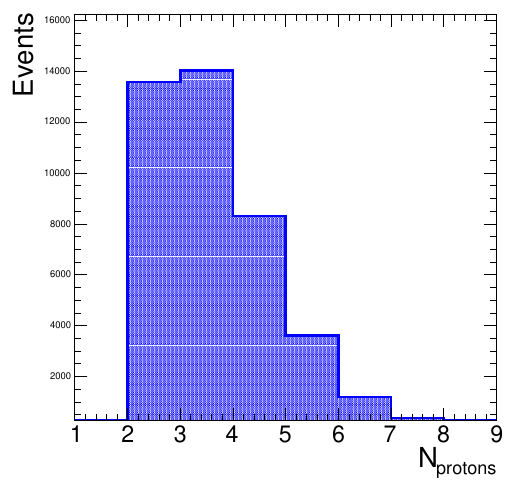
Figure 5 . Multiplicity of pile-up protons passing the 0 : 008 < (cid:24) < 0 : 2 FDs acceptance. The average number of pile-up is < N PU > =30 per event. The number of generated pile-up events are 100k.